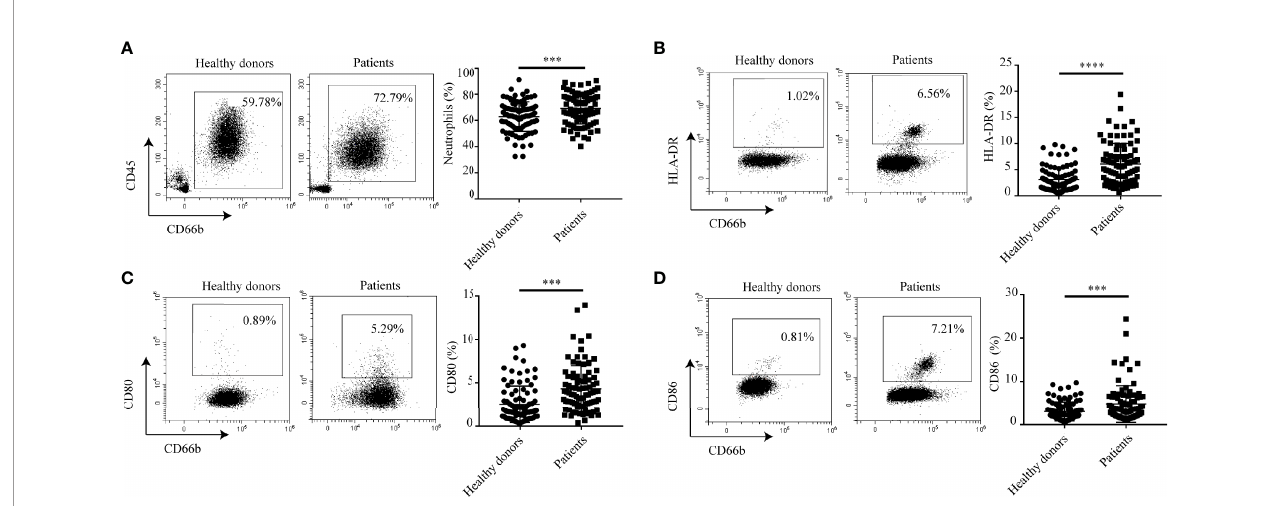
FIGURE 1 | Neutrophils express characteristic surface molecules of APCs in hyperlipidemic patients. (A) The percentage of neutrophils in peripheral blood of patients with hyperlipidemia and healthy donors. (B – D) Flow cytometry analysis of the percentages of HLA-DR + , CD80 + , CD86 + neutrophils between patients with hyperlipidemia and healthy donors. ***p < 0.001, ****p <